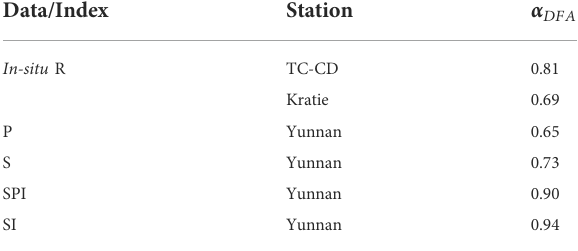
TABLE 3 α DFA of different hydrological variables or